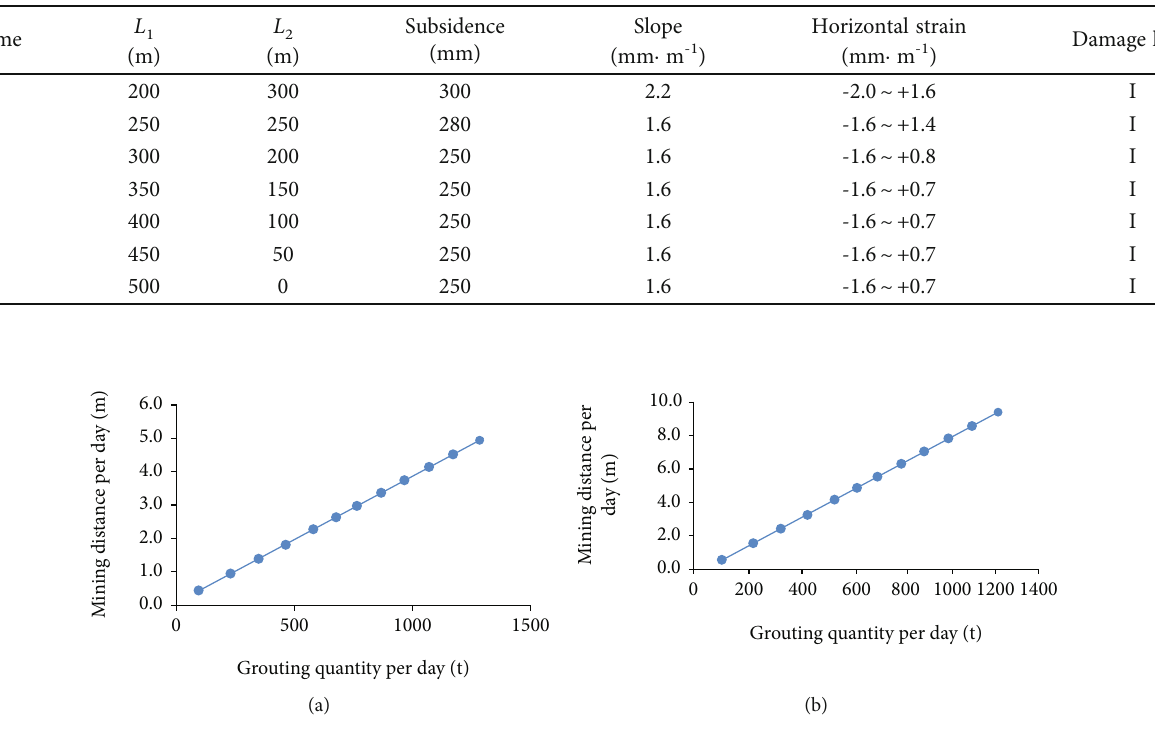
Figure 7: Panel layout with grouting. Table 3: Villages subsidence prediction for the di ff erent mining schemes with grouting.